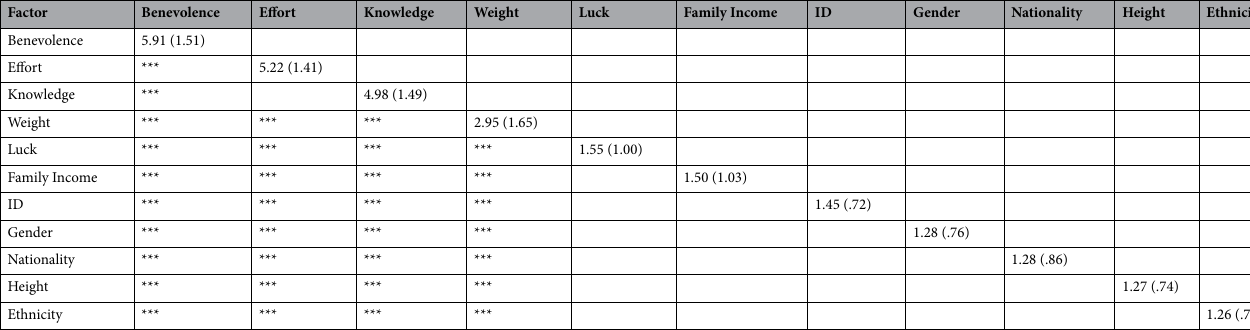
Table 4. Mean control and Wilcoxon signed-rank test comparisons. Notes: Standard deviations are indicated in parentheses. Stars in a cell indicate that the factor in the column is under more control than the factor in